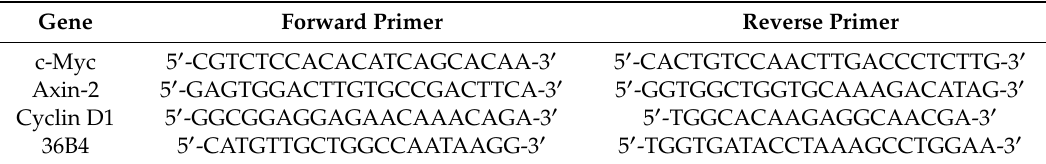
Table 1. Primer sequences for quantitative real